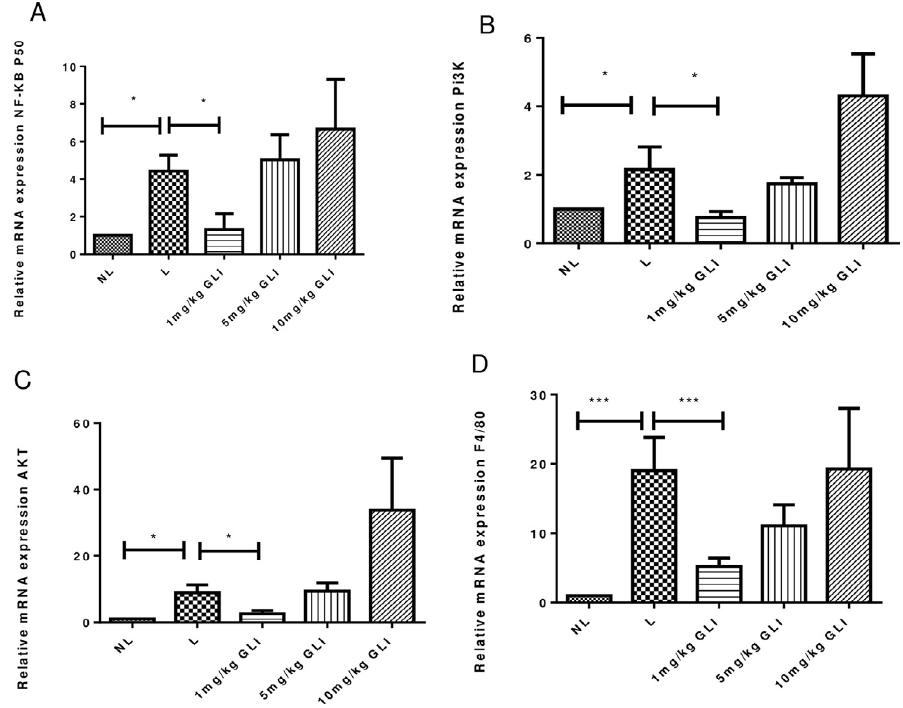
Figure 10- Effects of gliclazide (GLI) on (A) NF-κB p50, (B) PI3K, (C) AKT, and (D) F4/80 mRNA expression in gingival tissue from rats without periodontal disease (no ligature) and those with periodontal disease (ligature and 1 mg/kg GLI groups). The expression of NF-κB p50, PI3K, AKT, and F4/80 mRNA was decreased in the 1 mg/kg GLI (p<0.05 and p<0.001) and no ligature (p<0.001) groups. Analysis of variance followed by Bonferroni’s test (n=5